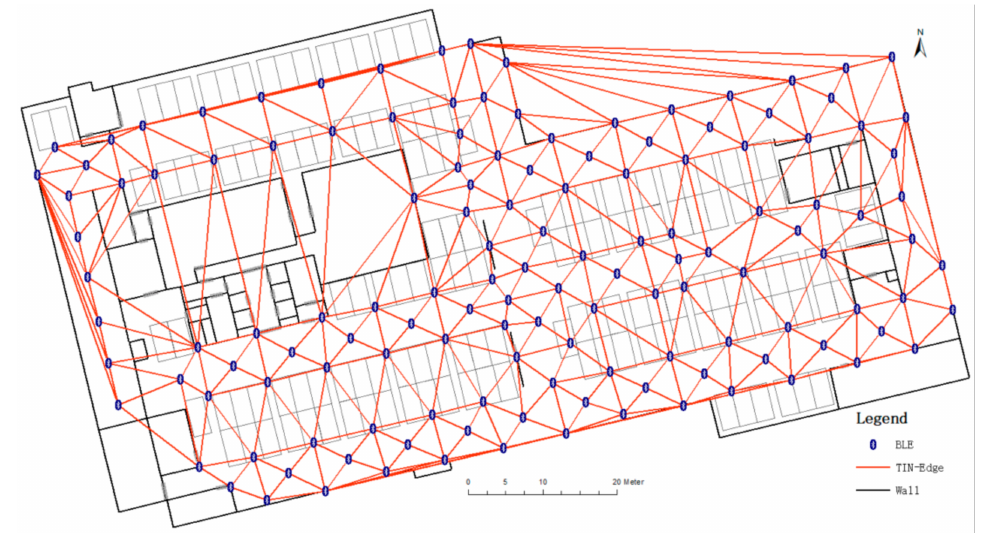
Figure 4. Connection relationship between beacons generated by TIN.